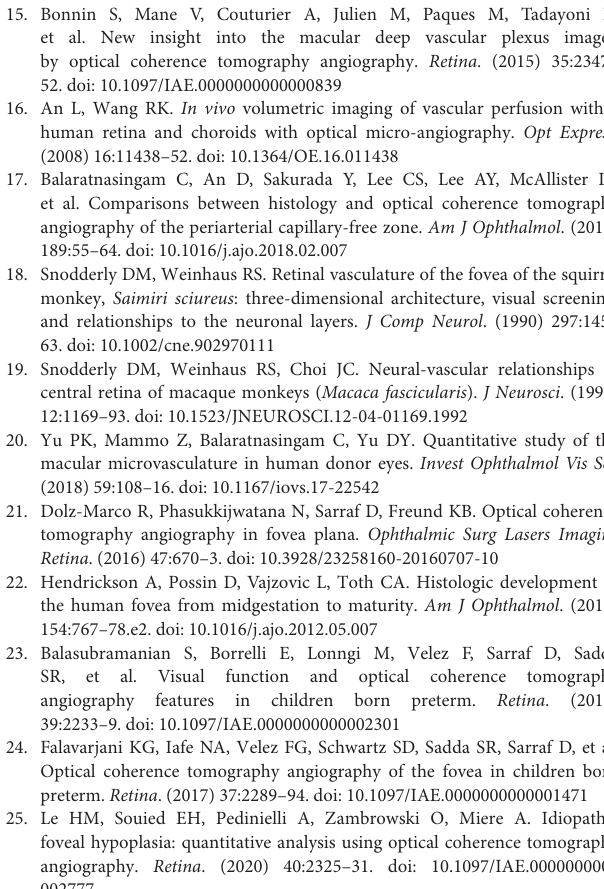
Supplementary Figure 1 | The image composition describes the imaging processing for the optical coherence tomography angiography (OCTA) en face slabs. The processing is reported for each single retinal capillary plexus [i.e., superficial (SVC), intermediate (ICP), and deep (DCP)] as outlined on the right side, where the segmentation used is also shown. The OCTA slabs were binarized and colored using the color merge function on Fiji software (http://fiji.sc; software